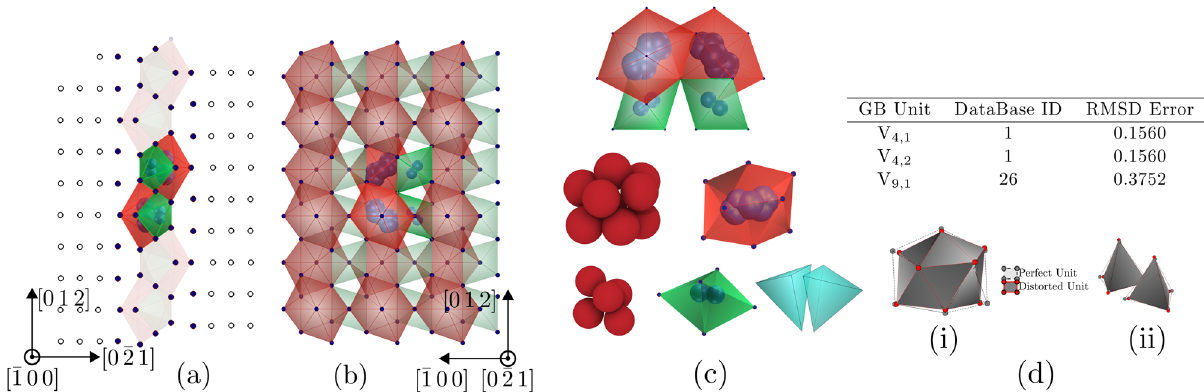
Fig. 9 The polyhedral unit model of the Σ 3 ð 101 Þ asymmetric tilt GB is illustrated. a , b The atomistic structure and the polyhedral units, along the tilt axis ½ 121 (cid:5) and the plane normal ½ 101 (cid:5) , are shown. The polyhedral units corresponding to the smallest asymmetric unit (the unit-cell) are highlighted. c The unit-cell polyhedral units, along with the overlapping VV-spheres (Bernal holes) and the clusters of atoms that correspond to the polyhedral units, are shown. The unique GB units are the 9-atom unit and the 5-atom dual-tetrahedron. The dual- tetrahedron is split further into two seed tetrahedra. The 9-atom GB unit best fi ts a 9-atom seed cluster in the data-base with RMSD error of ∼ The rest of the structure primarily consists of the CTPs, which is a identi fi ed polyhedra. The classi fi cation of these units is described signature of the Σ 3 ð 211 Þ GB. The Σ 3(18,9,8) contains the fi fteen- in section S3.3.2 of the Supplementary Information. In Fig. 12, we present the structure of Σ 3(18,9,8) GB, which is an atom polyhedral unit that corresponds to the ledge observed in Σ 3 ð 945 Þ . Additionally, Σ 3(18,9,8) also contains an in fi nite cluster interface with mixed character. The polar coordinates of the GB are ( θ , ϕ ) = (21.1°,5.21°) and the position of the GB in the Σ 3 BPl of atoms (shown as orange units). This unit represents regions that fundamental zone is shown in Fig. 6a. While the GB has both twist have higher excess-volume as the Voronoi spheres overlap with and tilt components, it has large facets corresponding to the Σ 3 each other along a large region in the GB. Figure 12c shows the (111) GB due to its proximity to the twin GB (as shown in Fig. 6a). side view of the in fi nite unit, which has the exact same